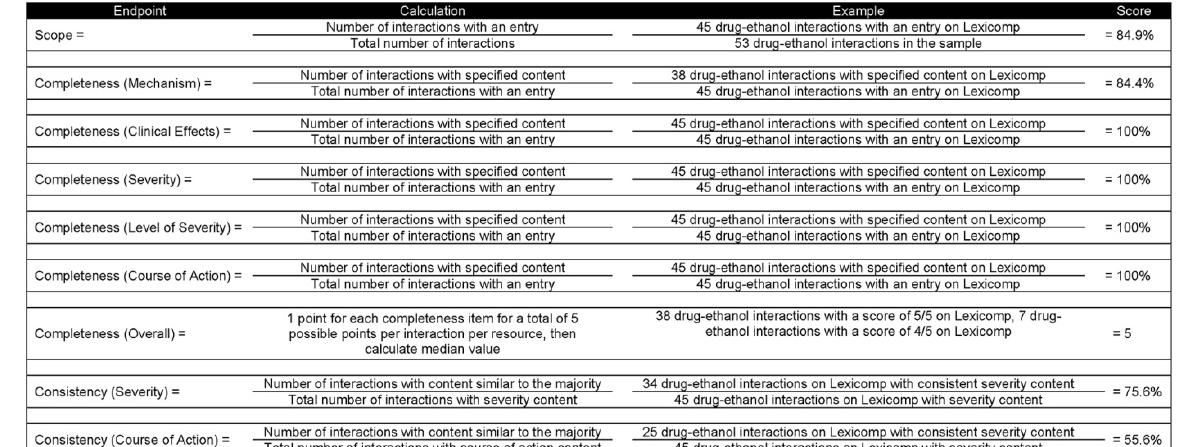
Figure 2 Full description of each endpoint along with an